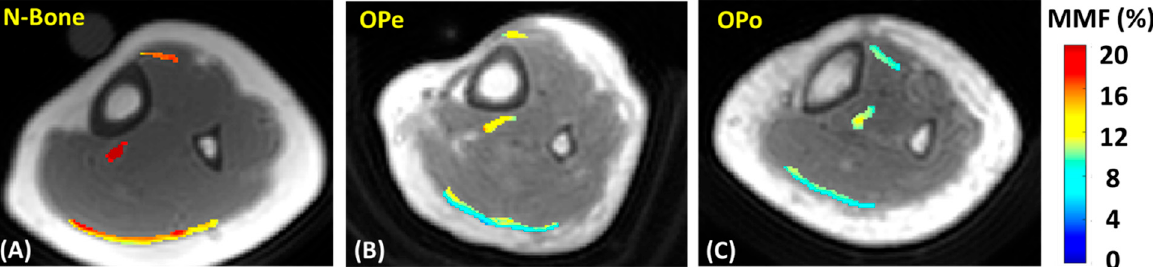
Figure 2. Generated macromolecular proton fraction (MMF) maps for exemplary participants from ( A ) Normal-Bone cohort (23-year-old female), ( B ) OPe cohort (83-year-old female), and ( C ) OPo cohort (85-year-old female). MMF was higher in Normal-Bone participant compared with OPe and OPo patients. N-Bone label refers to Normal-Bone group. Table 1. Mean and standard deviation of T1 and UTE-MT measurements in ATT, PTT, and PAT for Normal-Bone, OPe, and OPo cohorts. Intraclass correlation coefficient (ICC) was also measured between the three independent readers. N-Bone label refers to Normal-Bone group. T1 (ms) MMF (%)